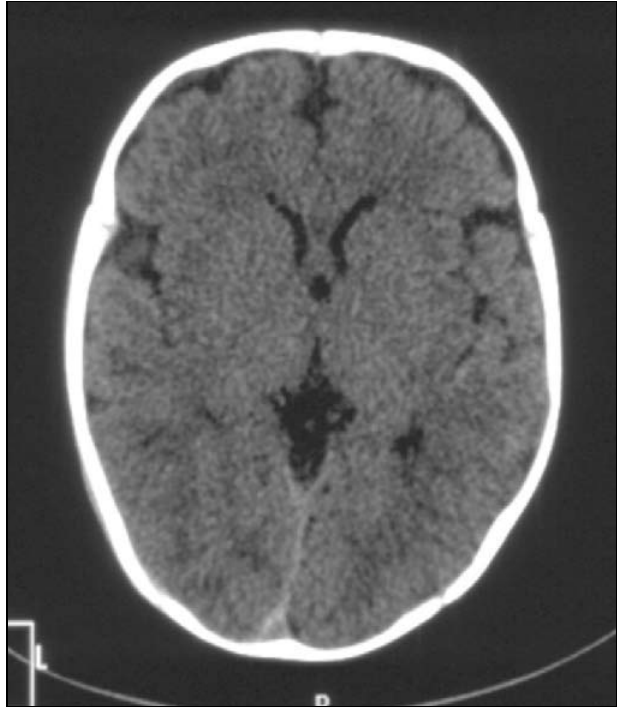
Fig.1. Non-contrast CT of the brain at the level of the Sylvian fissures demonstrates a subarachnoid bleed with the pseudo-delta sign. Fig. 2. CT of the brain with bone windows demonstrates a linear right parietal